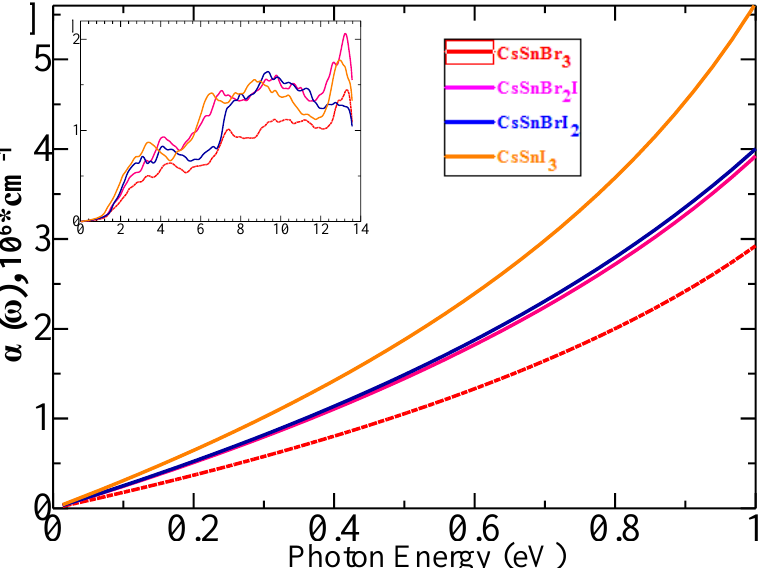
Figure 3. The calculated value of α (ω) for CsSnBr 3 , CsSnIBr 2 , CsSnI 2 Br and CsSnI 3 depending on the photon energy (insert: absorption coefficient ranging from 0 to 14